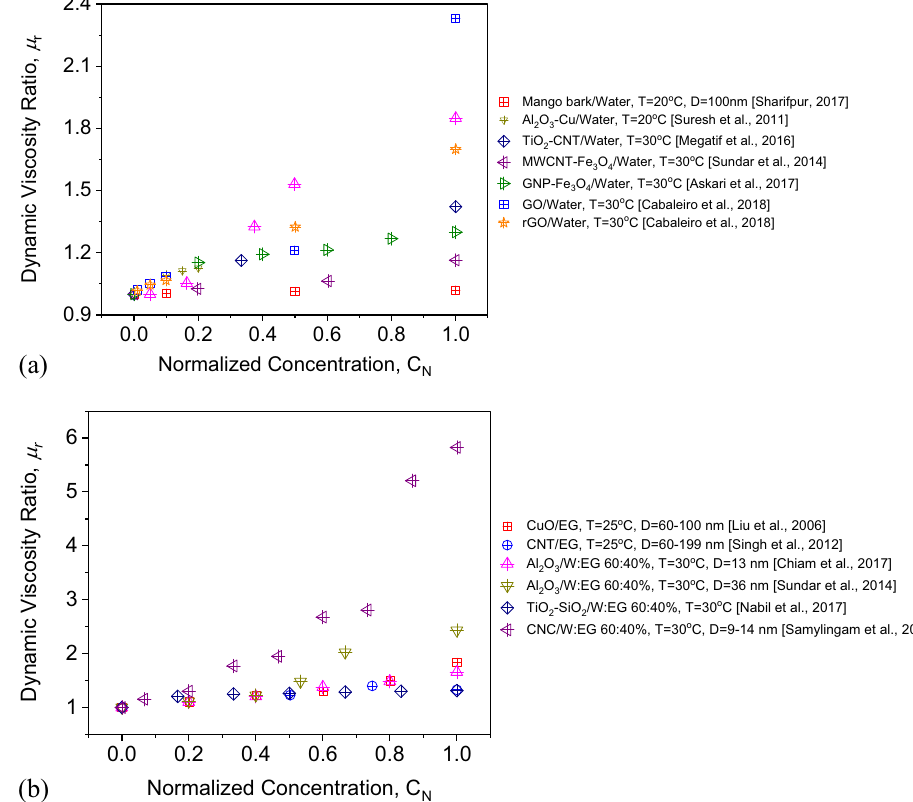
Figure 8: E ff ect of concentration on dynamic viscosity: ( a ) water and ( b ) EG and W:EG 60:40%